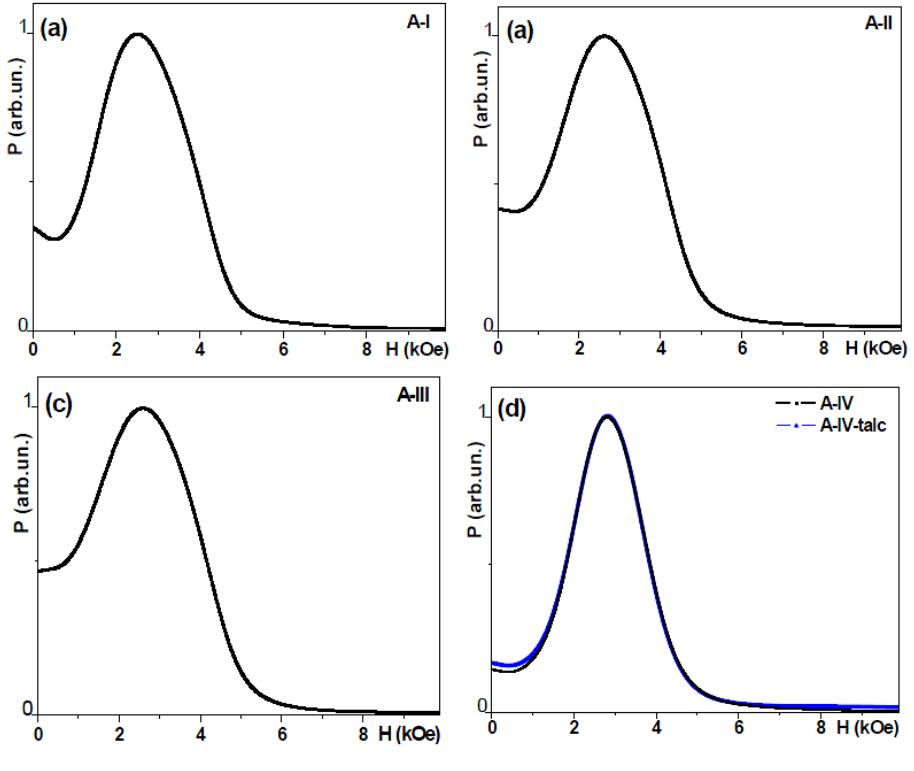
Figure 5. Microwave absorption as a function of the external magnetic field for Series A samples, f = 9.5